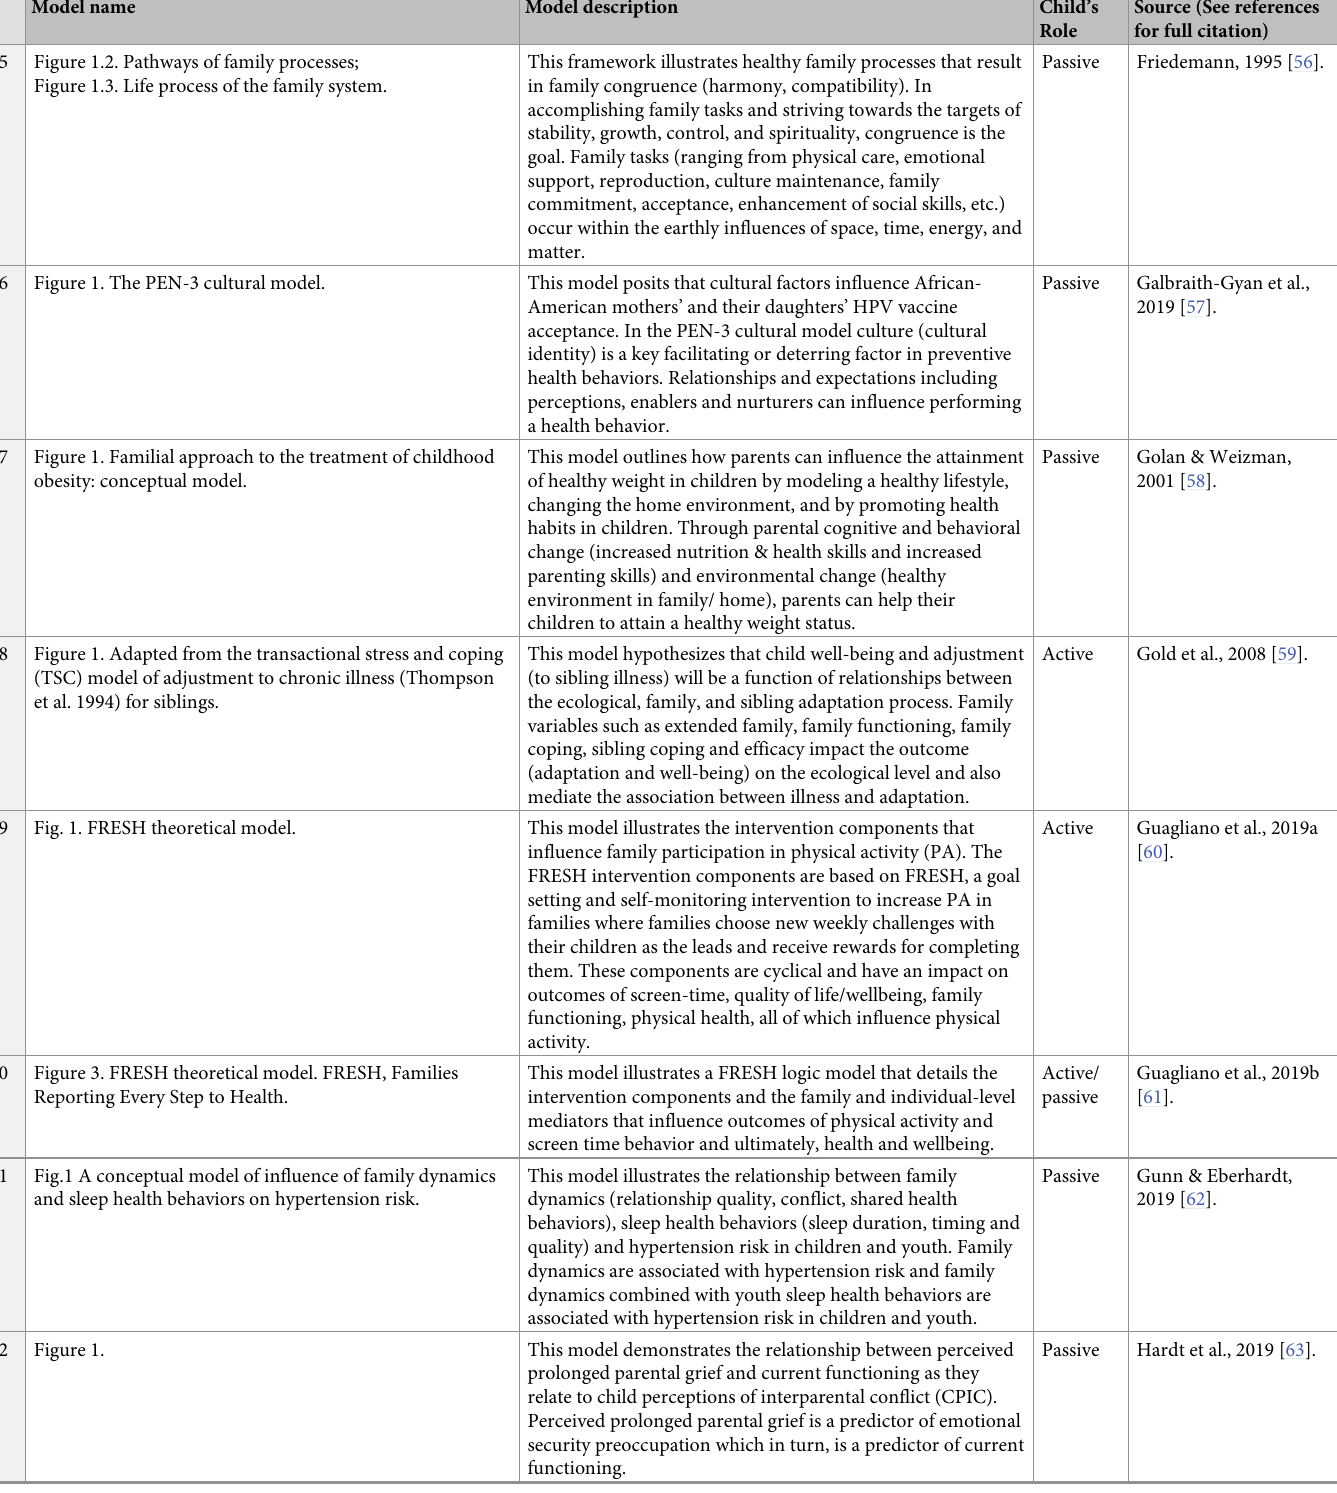
Figure 1.2. Pathways of family processes; Figure 1.3. Life process of the family system.